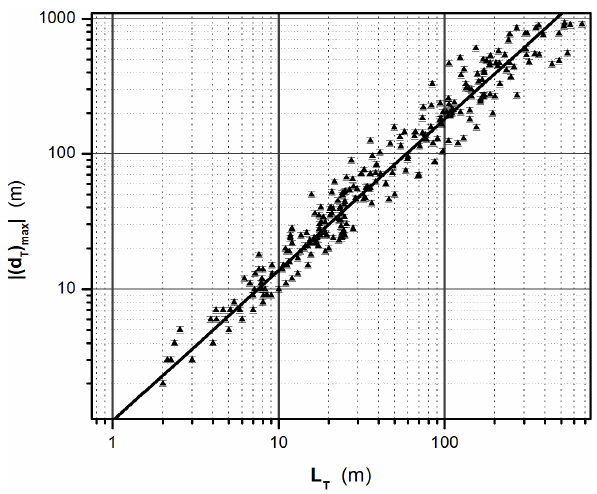
Figure 5. Absolute value of the maximum Thorpe displacement versus the Thorpe scale for the daytime data set ( (cid:78) ). The linear fit is indicated by the continuous black line.